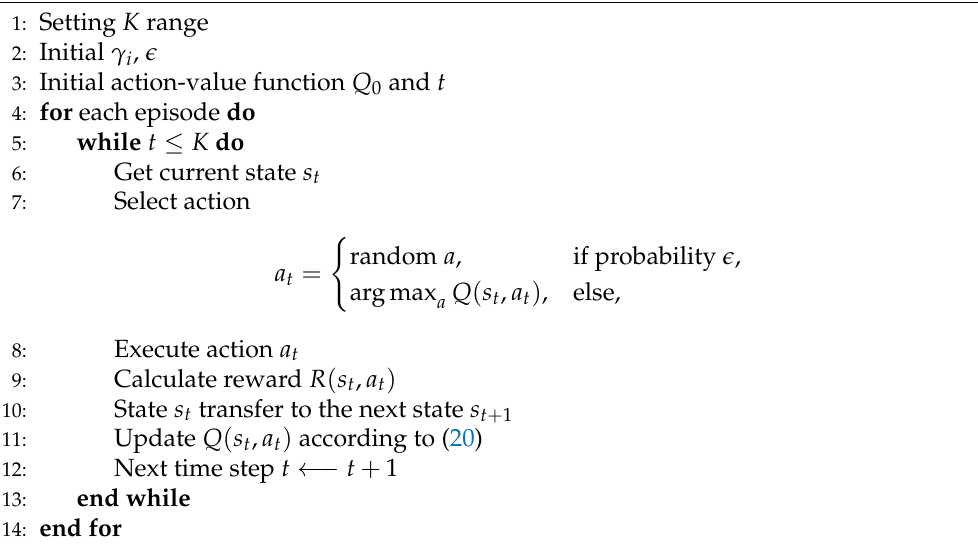
Algorithm 1 Q-Learning based solar panel control